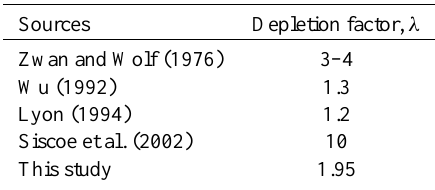
Table 2. Comparison between the depletion factors from different